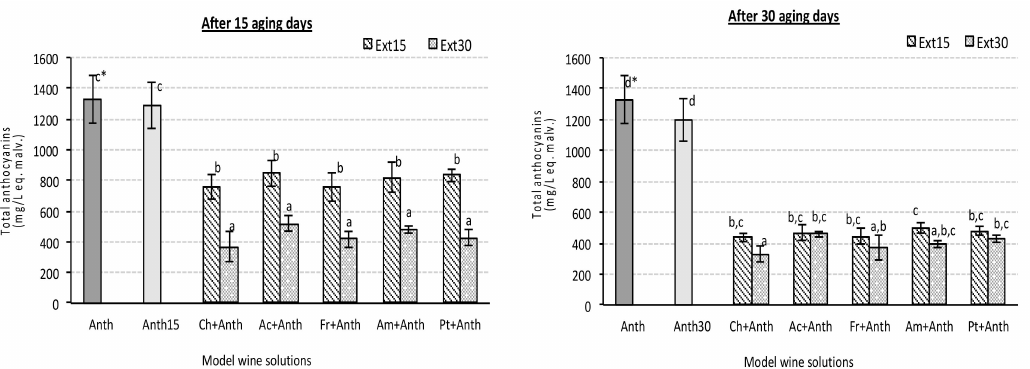
Figure 2. Total anthocyanins quantified in experimental red synthetic wine solutions containing di ff erent wood chip extract species and anthocyanin grape skin extracts after 15 and 30 aging days (sample codes see Table 1). All data express the average of four replicates ± standard deviation; * data points showing the same letter are not significantly di ff erent ( p <